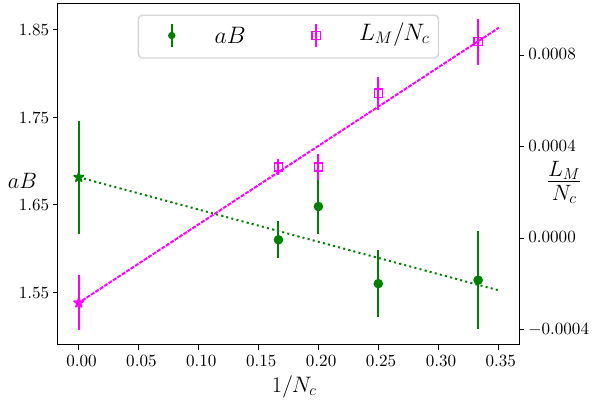
Fig. 3 N c dependence of B and L M . The dotted lines are the best fits to Eqs. (5) and (7) including all